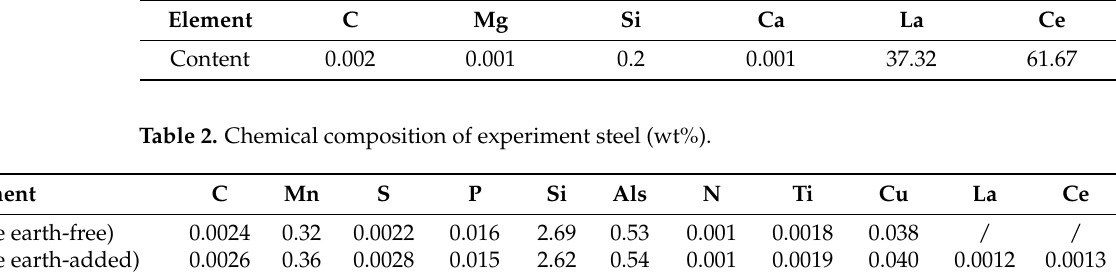
Table 1. Chemical composition of rare earth La–Ce alloys (wt%).